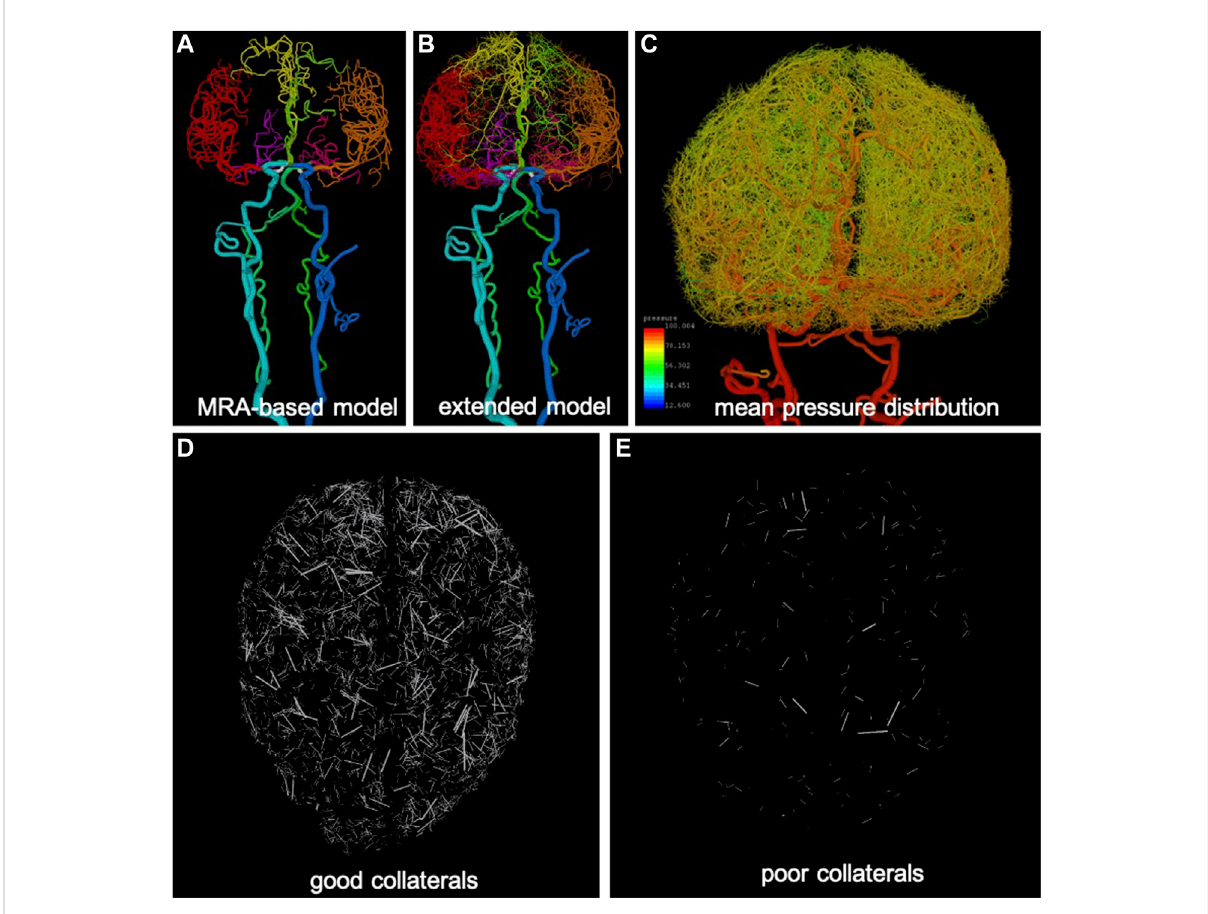
FIGURE 1 Anatomical model construction: (A) arteries reconstructed from MRA images (different arterial trees are rendered with different colors), (B) extension of arterial trees using CCO approach (intermediate stage), (C) pressure distribution calculated along arterial trees and used for generation of collateral vessels in extended arterial model, (D) example of good level of collateralization (superior-inferior view), only collateral branches are visualized, and (E) example of poor